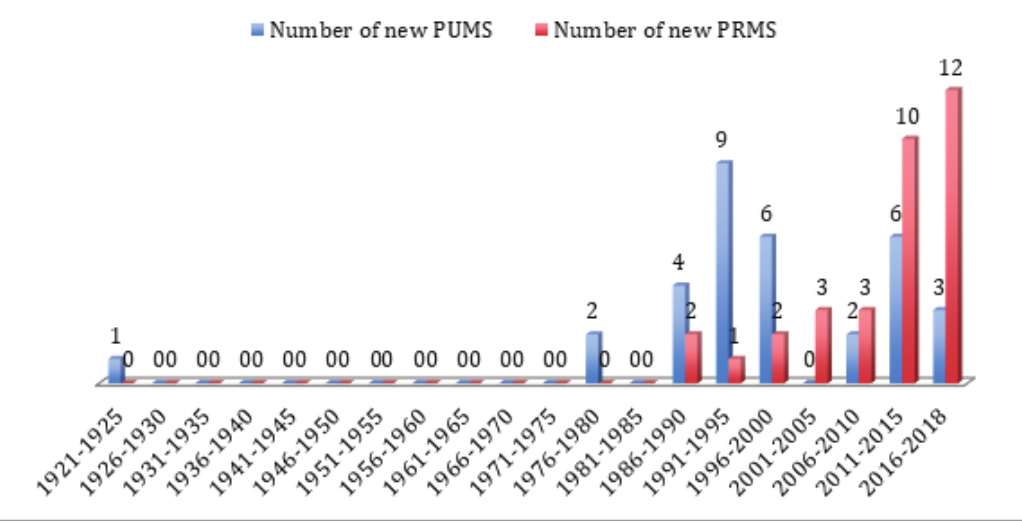
Figure 1: The MS Number, type and year of Establishment.